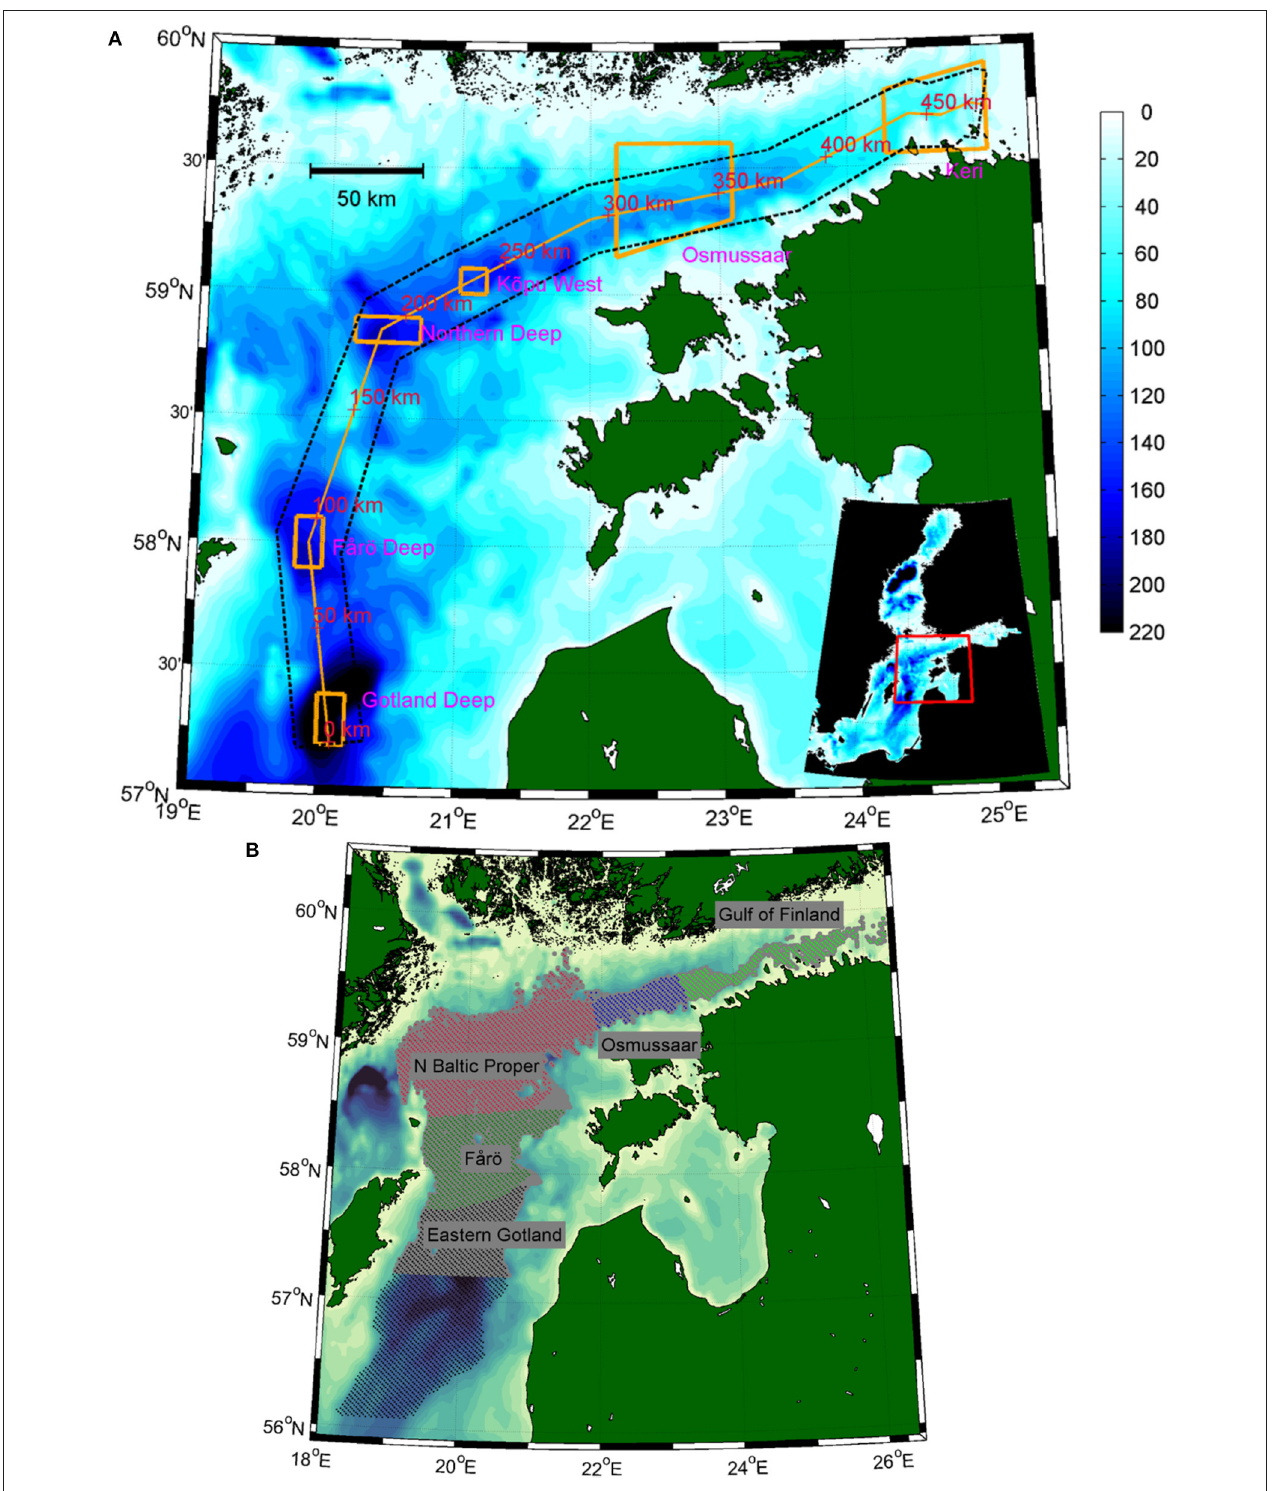
FIGURE 1 | (A) Map of the study area in the Baltic Sea (inlay). Orange line maps the pathway under investigation from the Gotland Deep to the Gulf of Finland. Black dashed lines determine the extent of cross-sections wherefrom data were collected for calculation of monthly mean parameters along the pathway. Orange boxes mark time-series areas Gotland Deep, Fårö Deep, Northern Deep, Kõpu West, Osmussaar, and Keri. Red numbers show the distance from the Gotland Deep along the pathway. (B) Map of the basins defined for quantification of the impact of MBIs in the water column below 80m depth. Gray area marks the basin from the Gotland Deep to the central Gulf of Finland. Following sub-basins are defined: Eastern Gotland Basin, Fårö Basin, Northern Baltic Proper, Osmussaar area, and Gulf of Finland.